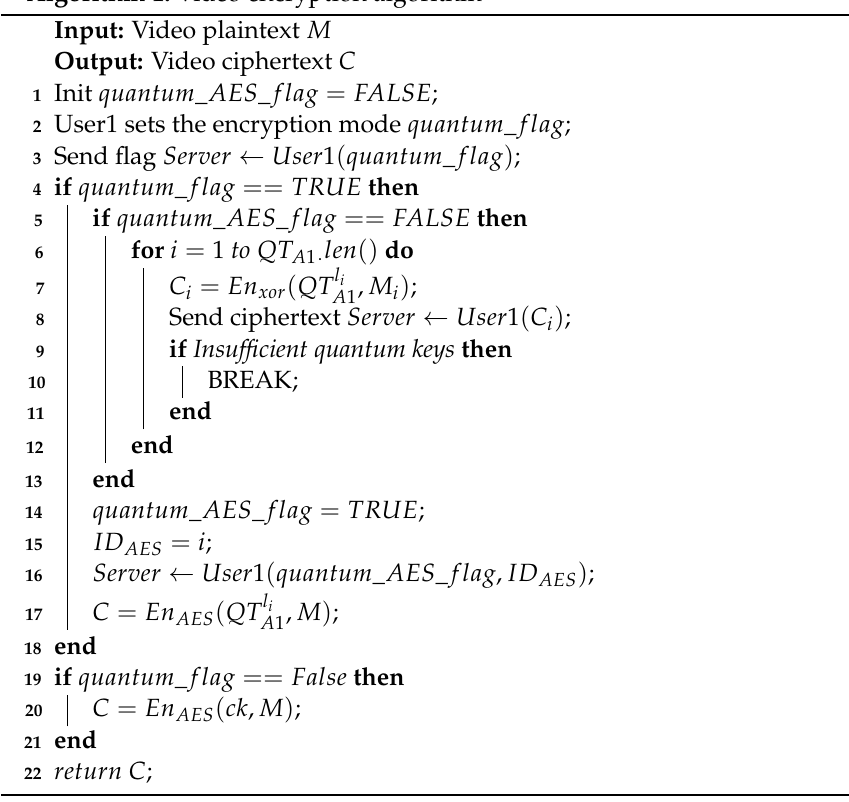
Algorithm 1: Video encryption